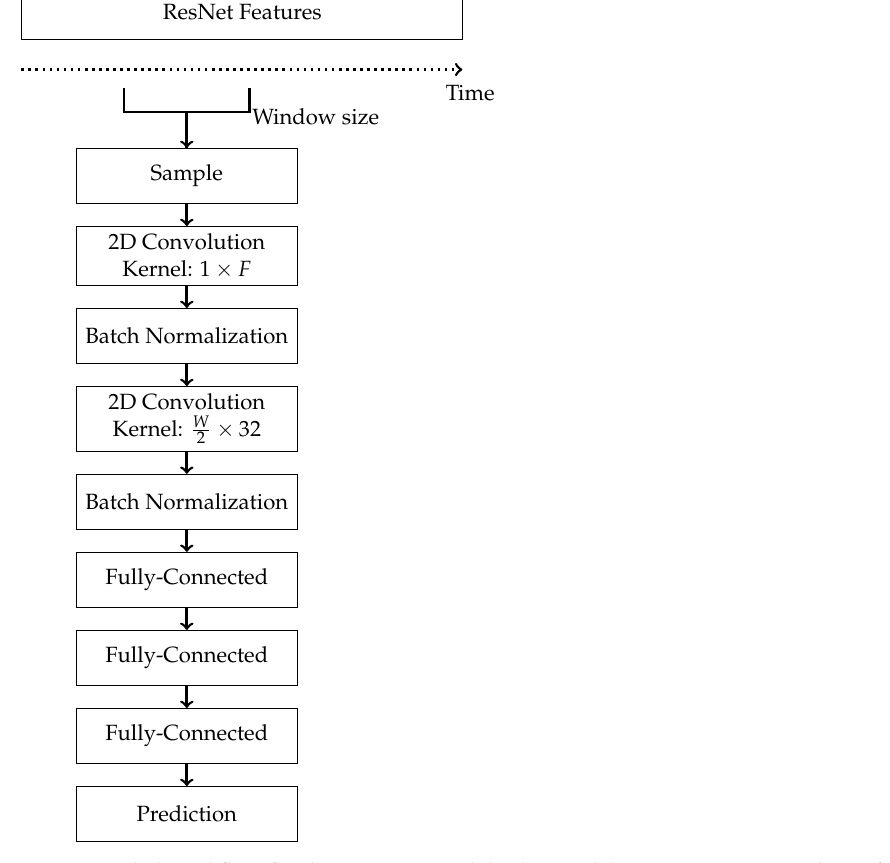
Figure 4. Detailed workflow for the 2D-CNN model. This model uses a pre-computed set of features and is tested with both visual and audio-visual (visual augmented with audio) features in our